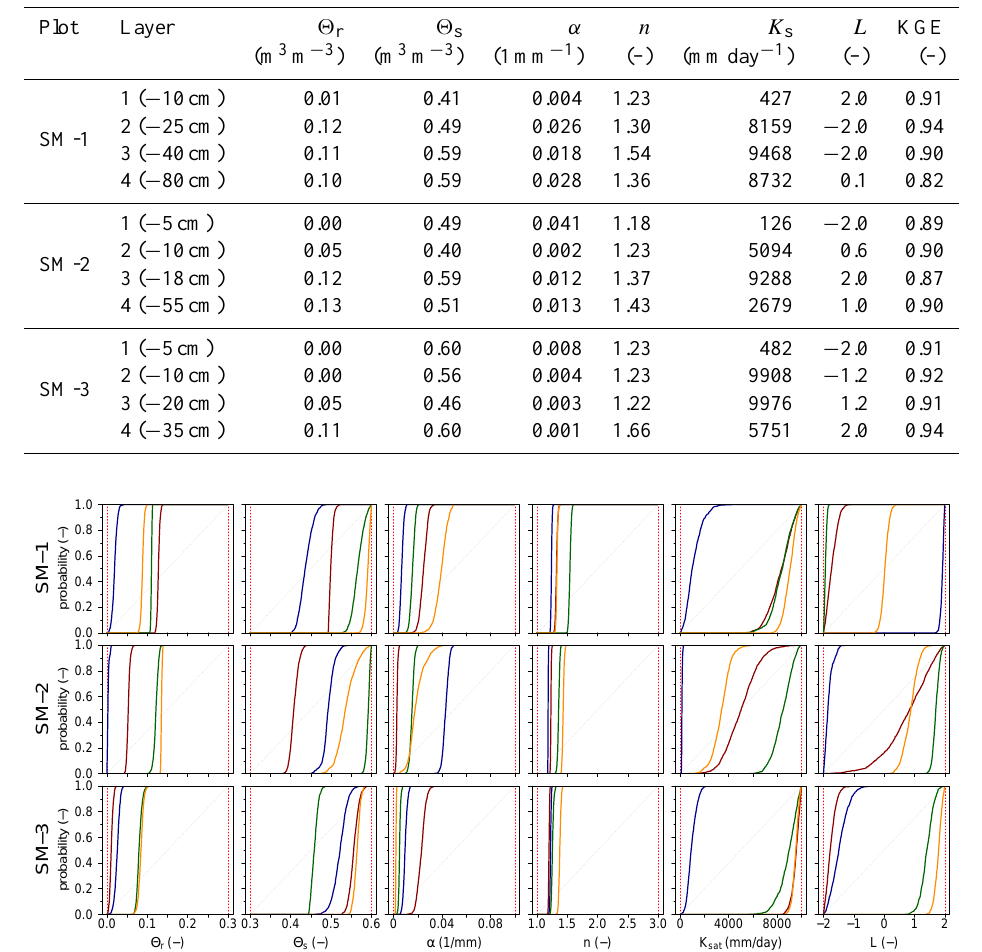
Figure 5. Observed volumetric soil moisture at different depths of the three experimental plots during the complete monitoring period (a) and details on the winter season 2011/2012 for plot SM-1 (b)